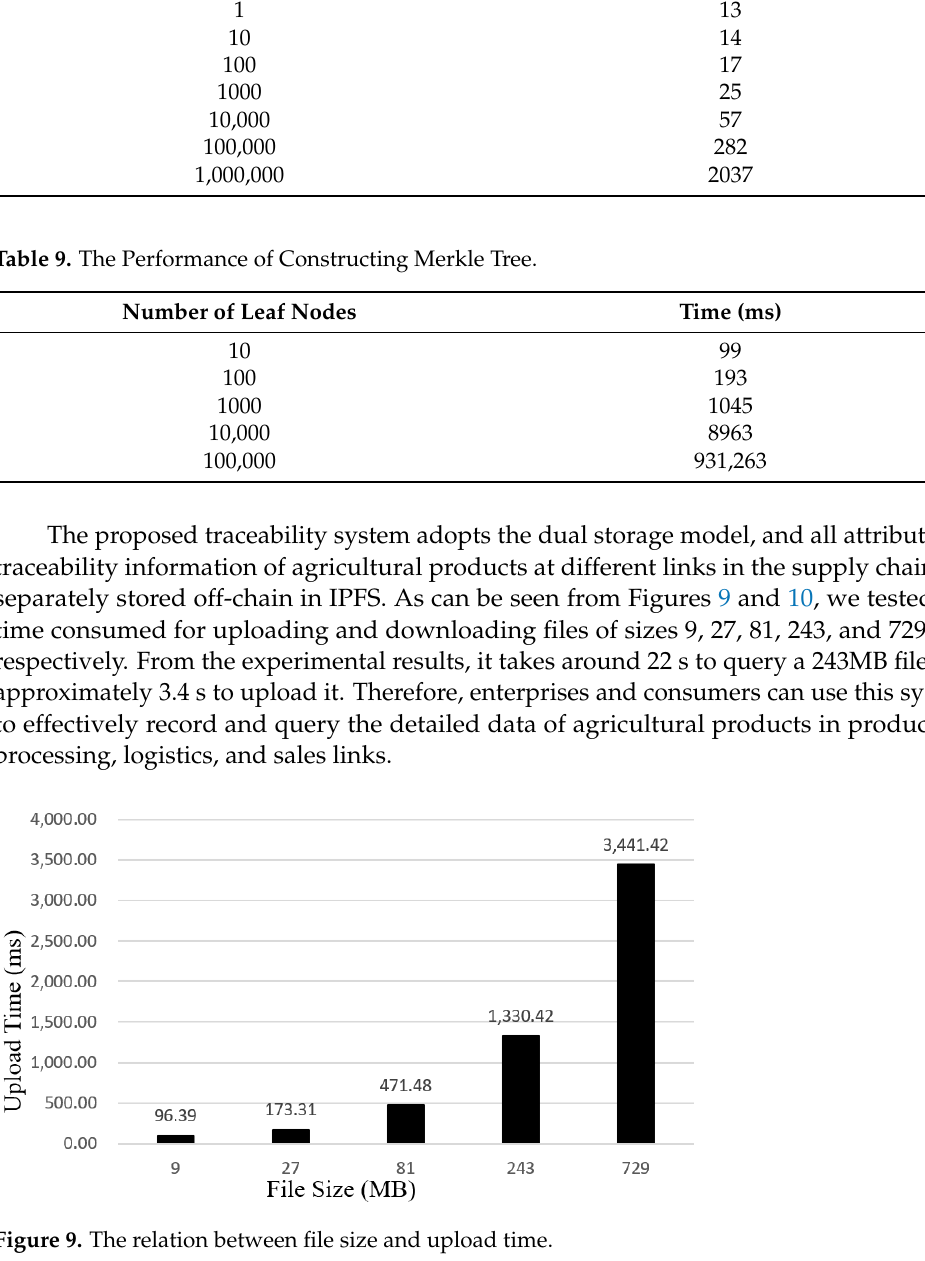
Figure 10. The relation between file size and query time. 5.4. Security Analysis In this subsection, we briefly discuss the security analysis of the proposed agricul- tural traceability system. First, the main goal of the proposed system is to keep track of all information and transactions that occur within the agricultural product supply chain, ensuring agricultural product traceability. This goal is ensured in the proposed system because all traceability information and transaction records of agricultural products are stored in the immutable blockchain ledger. Second, the proposed system adopts the dual storage model of “ Block- chain+IPFS ” , in which large-size information is stored off-chain and small-size key infor- mation is stored on-chain. Because both the Ethereum Blockchain and IPFS are decentral- ized platforms that do not require a central server, even if the system receives malicious attacks such as a Denial of Service (DoS) attack, all functions are still available. Third, the proposed system uses the modifier features of the Ethereum smart contract to qualify the execution conditions of each function. Therefore, all function callers can be traced, and they are accountable for their actions. Finally, it is critical to protect the trace- ability information against forgeries in the agricultural product supply chain. In our sys- tem, only enterprises authorized by government regulators are granted access to critical functions. Additionally, the system uses smart contracts to ensure that the traceability in- formation of each agricultural product can only be uploaded by the designated enterprise and cannot be modified once uploaded.